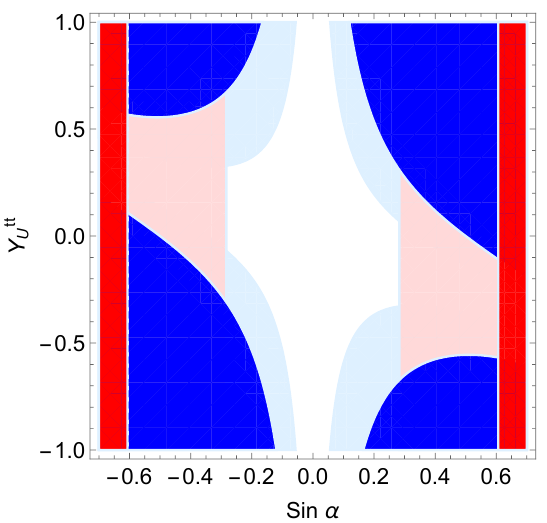
Figure 14. The excluded parameter space in the plane of Y tt dark red regions are excluded by the LHC run-1 ggh coupling and WWh coupling measurements respectively. The light blue and light red regions are the predicted exclusion regions from the ggh and the WWh couplings measurements at the 14 TeV LHC with 300 fb (cid:0) 1